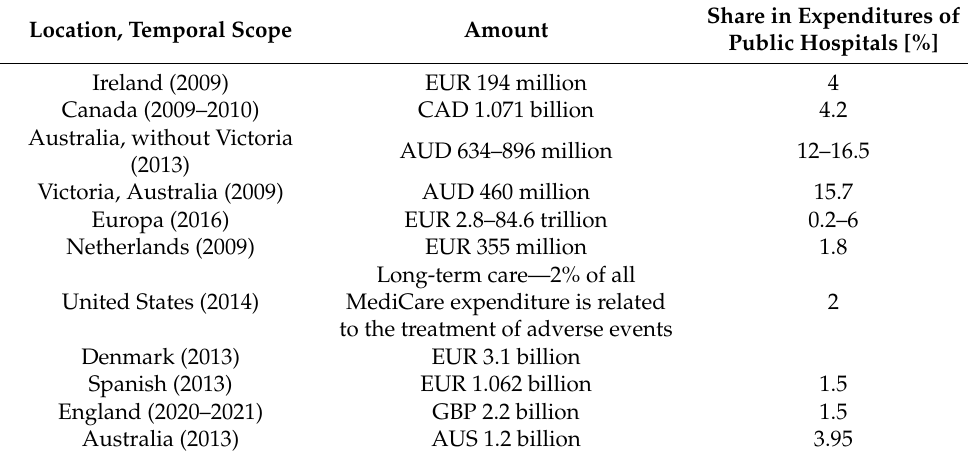
Table 5. Costs of adverse events in hospitals